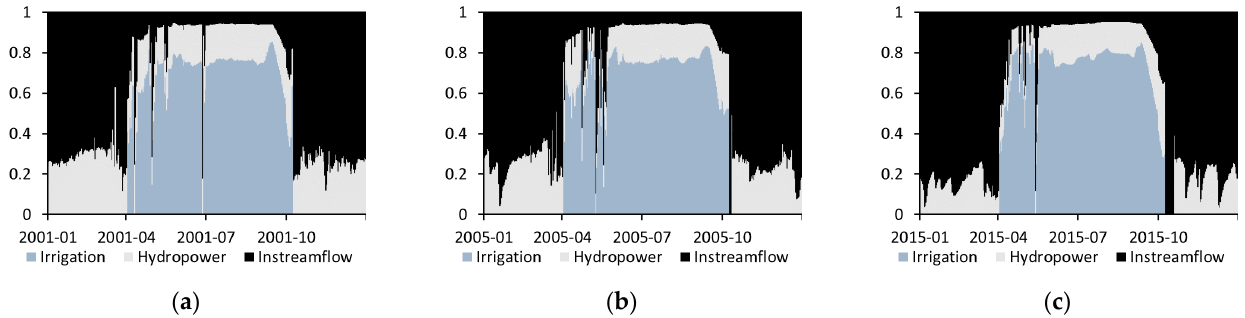
Figure A2. Fractions of ( a ) instream flow, ( b ) hydropower water withdrawal, and ( c ) irrigation diversion over total allocated water.